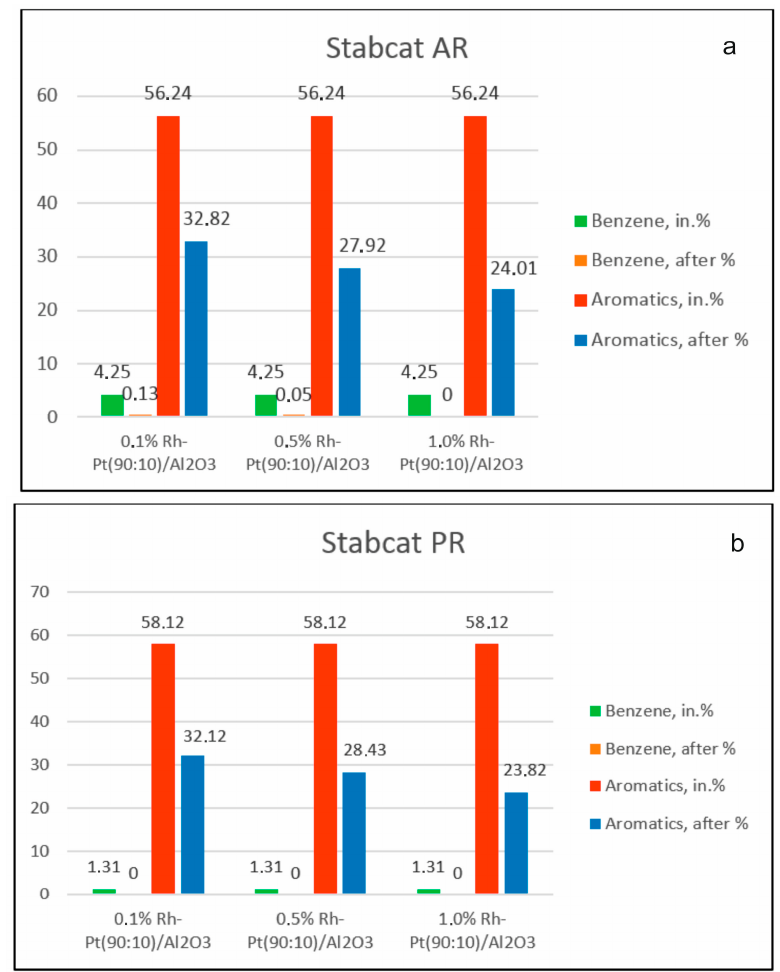
Figure 1. Hydrogenation of fractions of stable catalysate AR ( a ) and stable catalysate PR ( b ) over 0.1% Rh-Pt/ γ -Al 2 O 3 , 0.5% Rh-Pt/ γ -Al 2 O 3 and 1.0% Rh-Pt/ γ -Al 2 O 3 catalysts at 100 °C and 4.0 MPa.